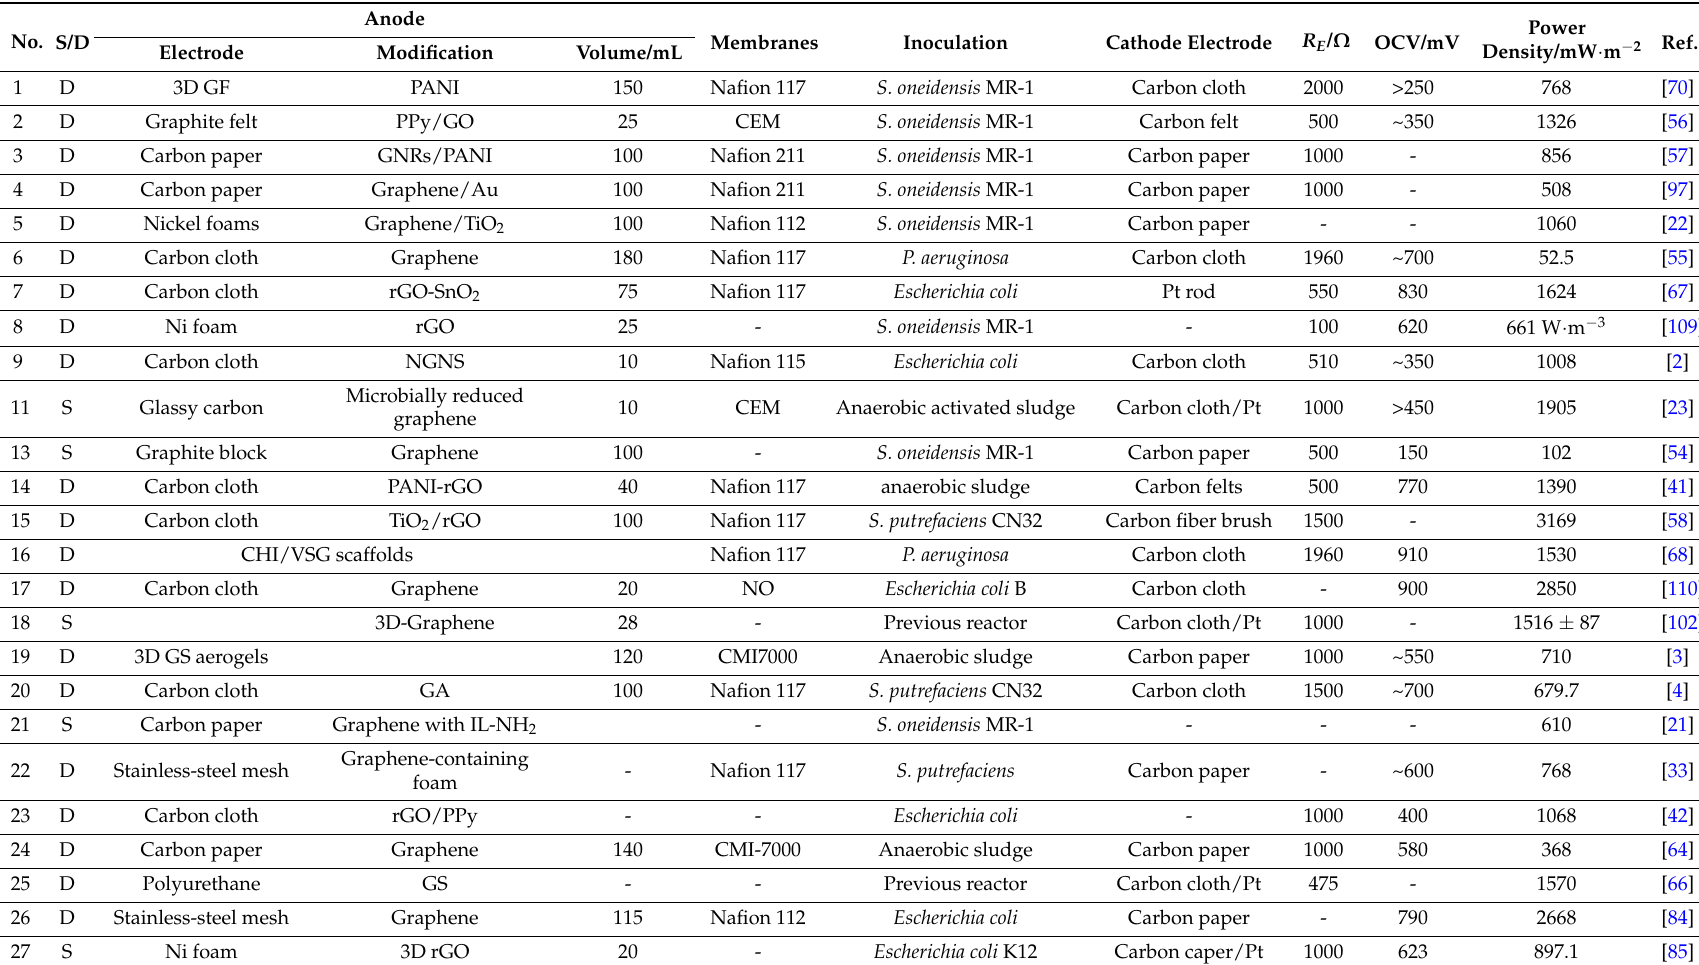
Table 1. Summary of microbial fuel cells (MFC) anode electrode